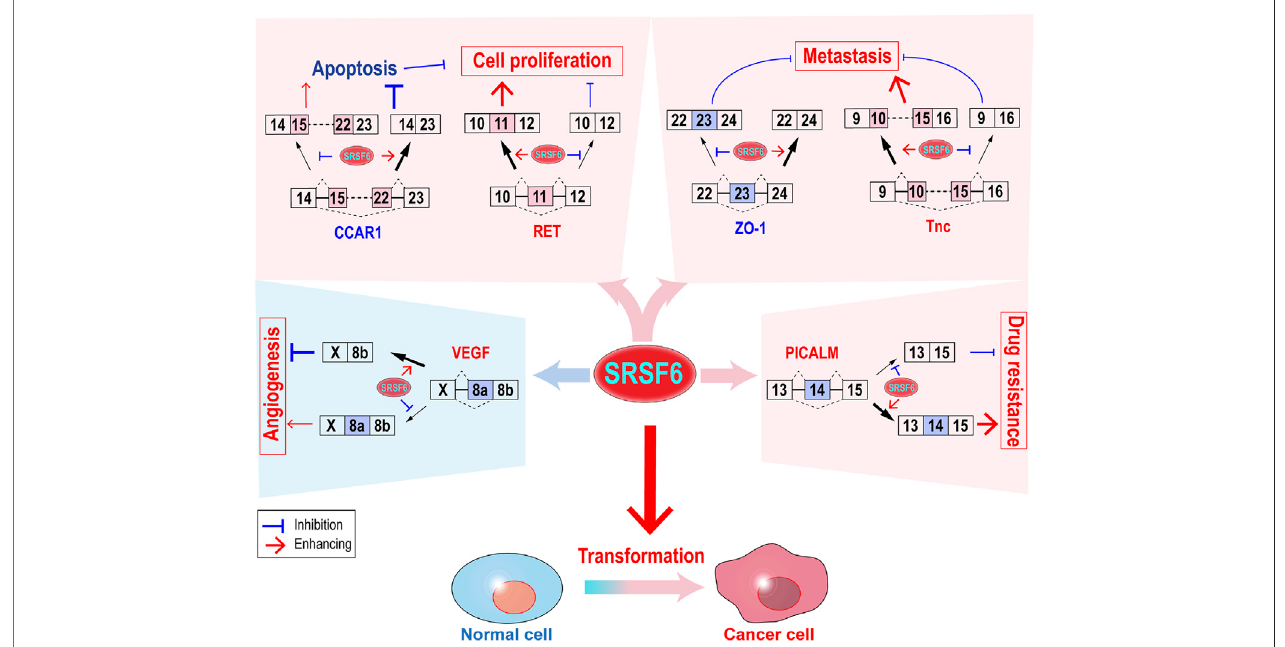
FIGURE2| FunctionsandregulatorymechanismsofSRSF6intumorigenesis.SRSF6cantransformcellsandcontrolthealternativesplicingofseveraltargetgenes to promote cell proliferation, metastasis, and drug resistance. SRSF6 may also play anti-cancer function by inhibiting angiogenesis.